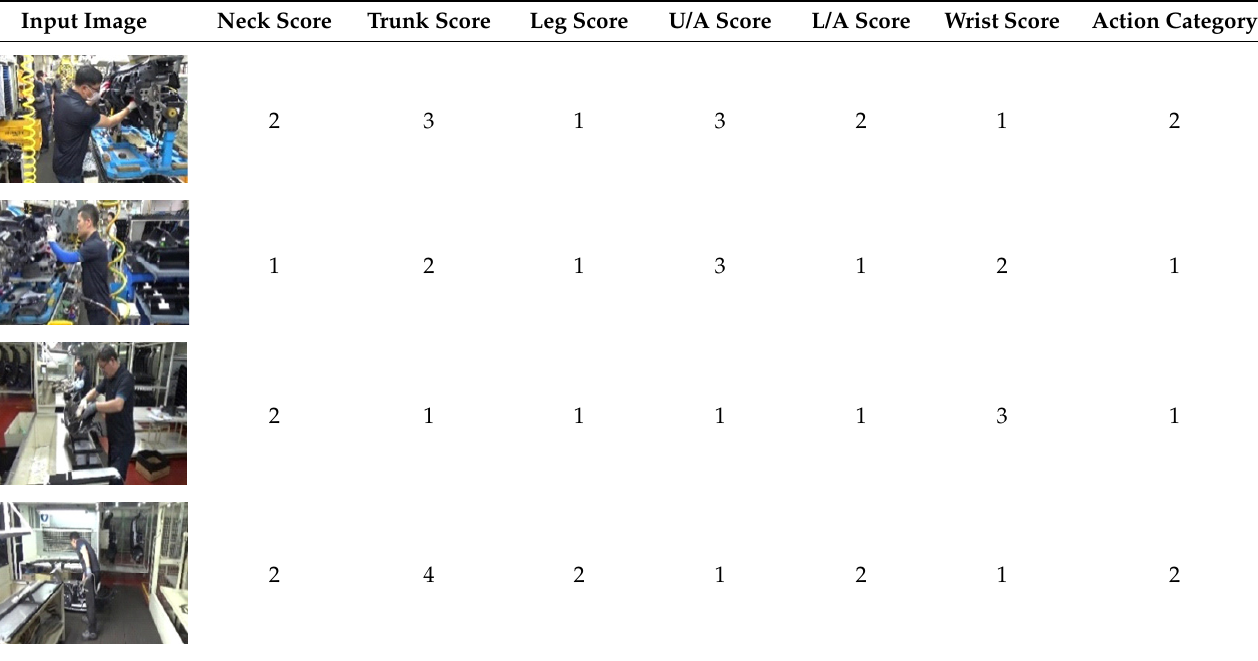
Table 3. Example of RULA score chart for input images. Input Image